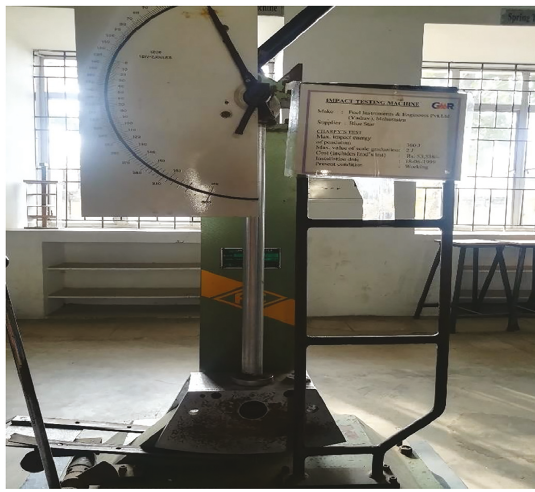
Figure 17: Impact testing machine.